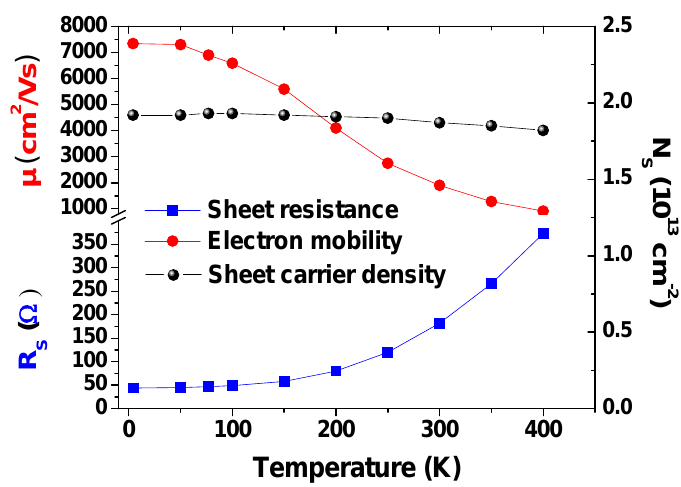
Figure 2. Sheet resistance (in blue), Hall mobility (in red) and sheet carrier density (in black) of the Si x N y /InAlGaN/AlN/GaN HEMT heterostructure as a function of temperature.